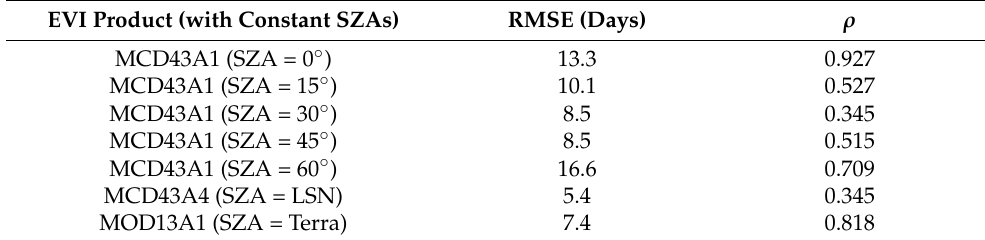
Figure 7. EOS derived from the EVI time series from 2001 to 2010. SZA = 0°, 15°, 30°, 45° and 60° denote the EOSs derived from the MCD43A1 (BRDF) product with a consistent angle configuration;